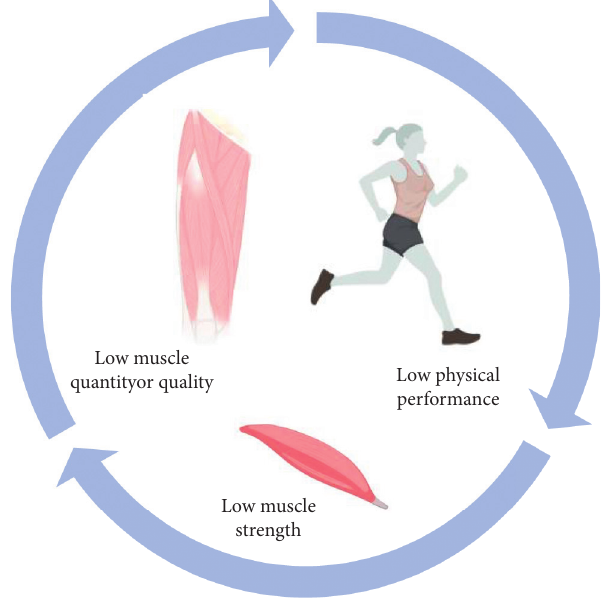
Figure 1: Sarcopenia impact on physical